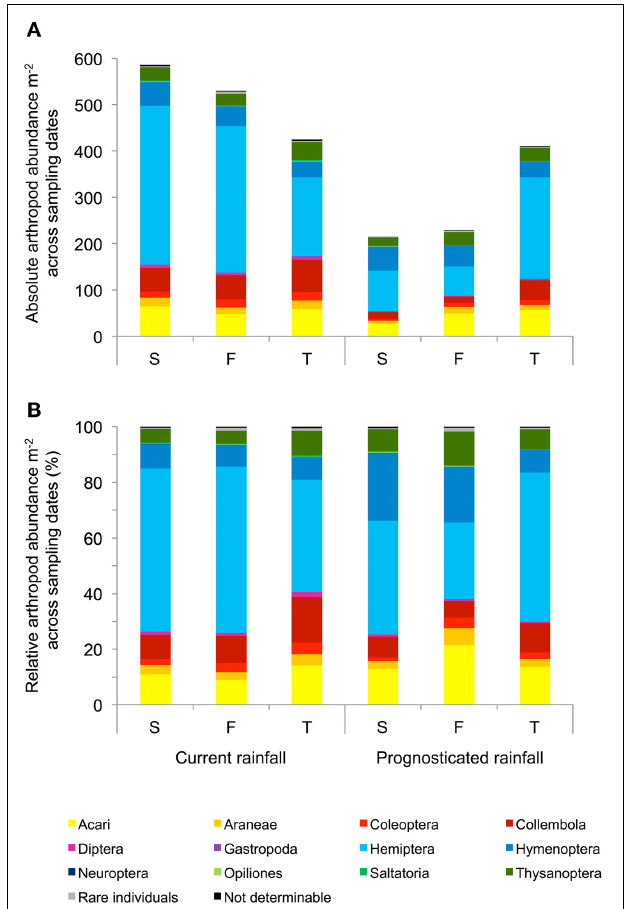
FIGURE 5 | Mean absolute (A) and relative (B) abundance of arthropods per m 2 across the three sampling dates (April, May, June) in winter wheat cultivated under current and prognosticated rainfall variations at the different soil types calcaric phaeozem (S), gleyic phaeozem (F) and calcic chernozem